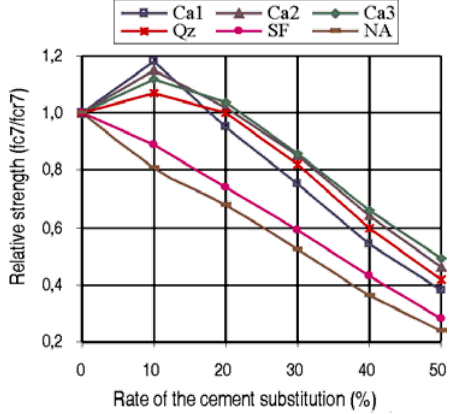
Fig 4. Effect of the cement substitution by the admixtures on the compressive strength of mortars in 7 days